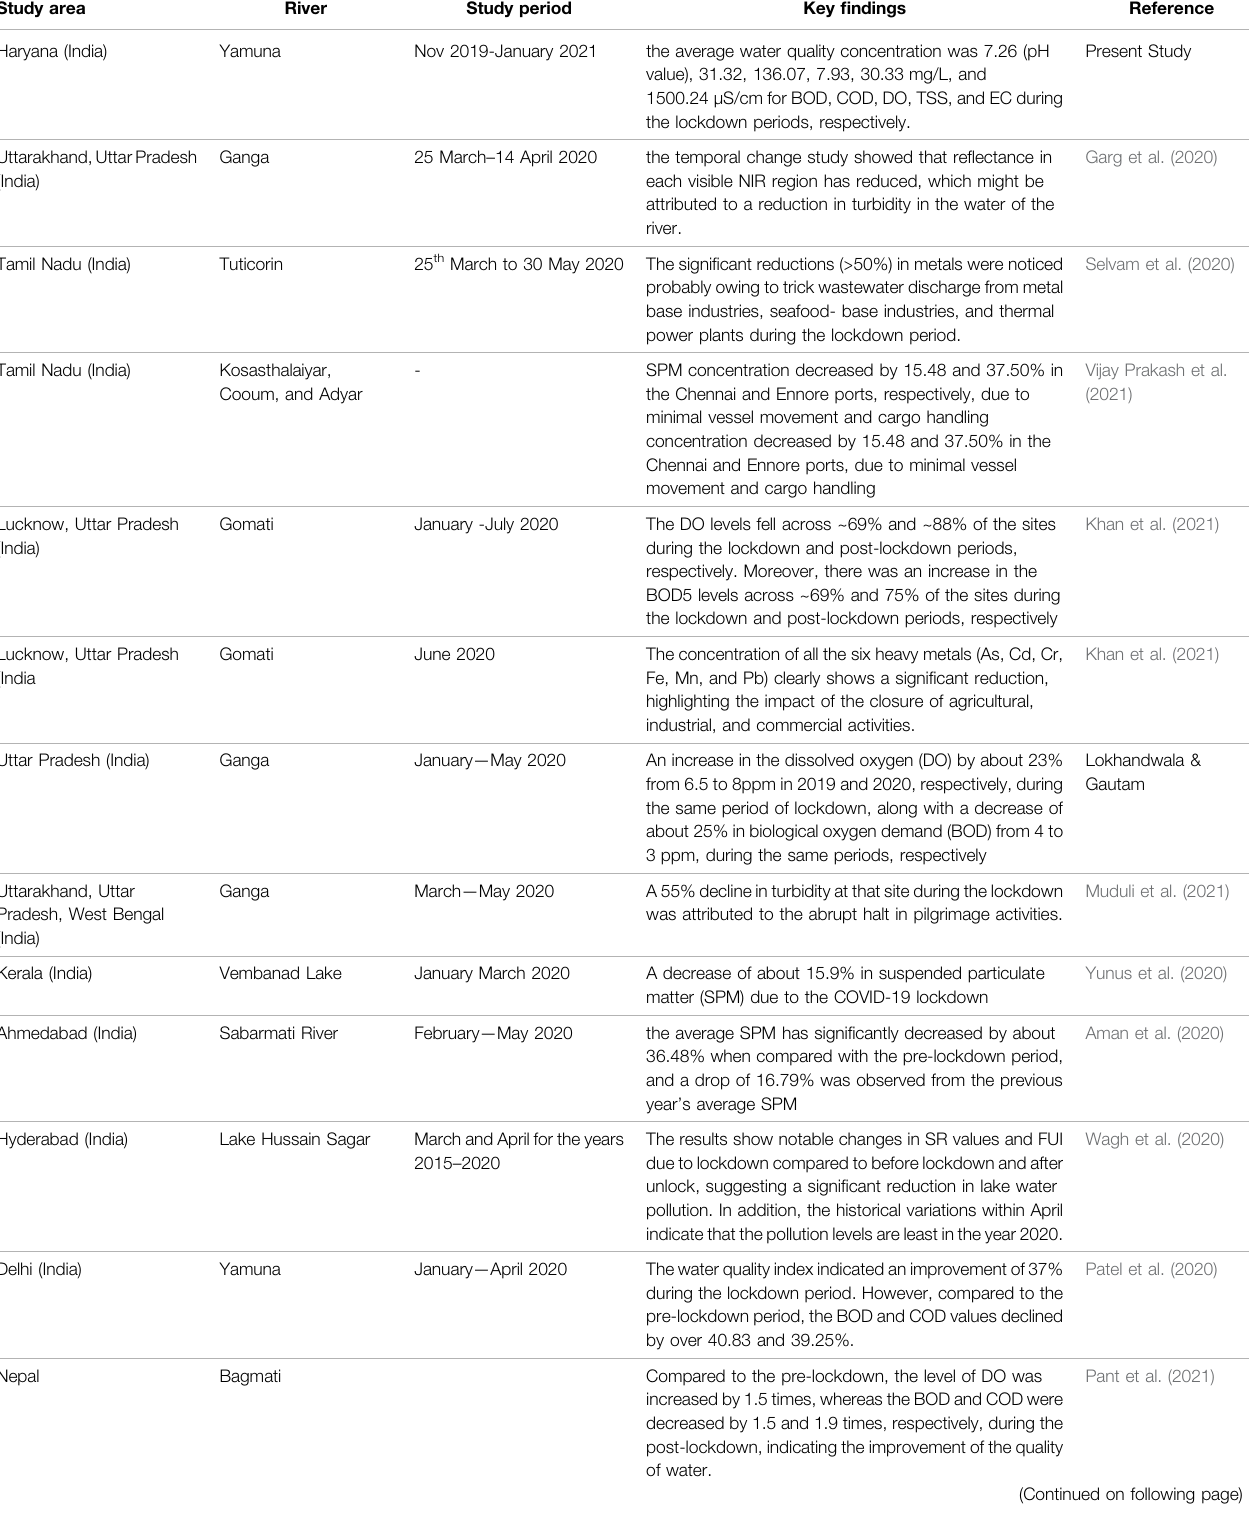
TABLE 1 | A comparative study of variation of environmental water quality parameters in different cities across the world during the pandemic. Study